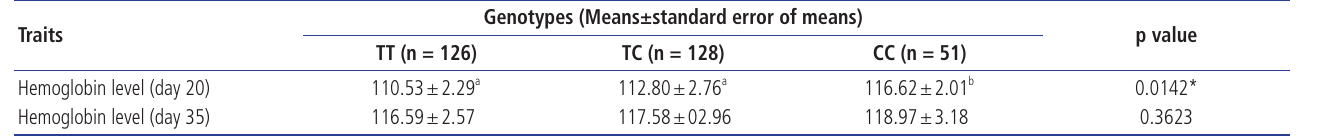
Table 3. Association analysis of hemoglobin level in three pig breeds Table 4. Association analysis and multiple tests of the SNP (g.29625094 T>C) of GYPC gene with hemoglobin level in three pig populations Traits